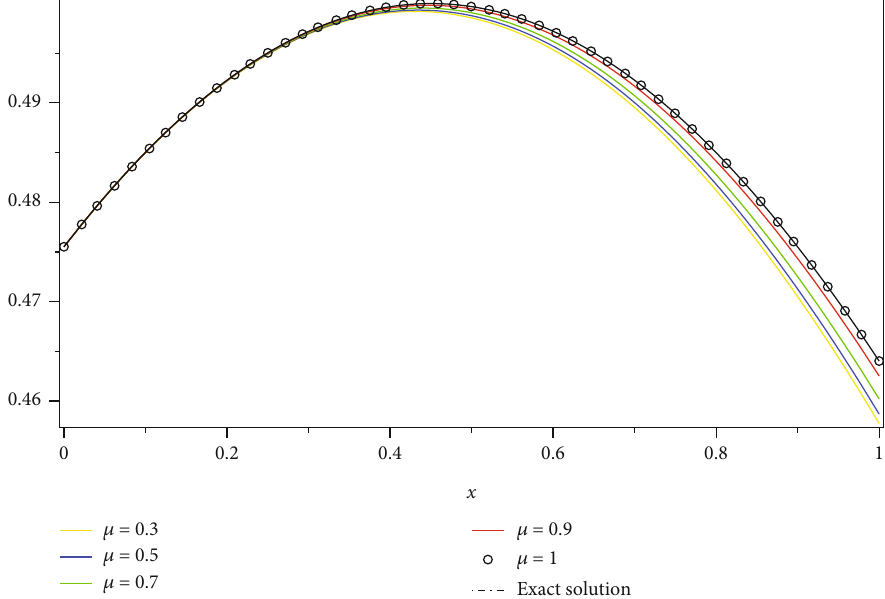
Figure 3: Exact and approximate solutions for k